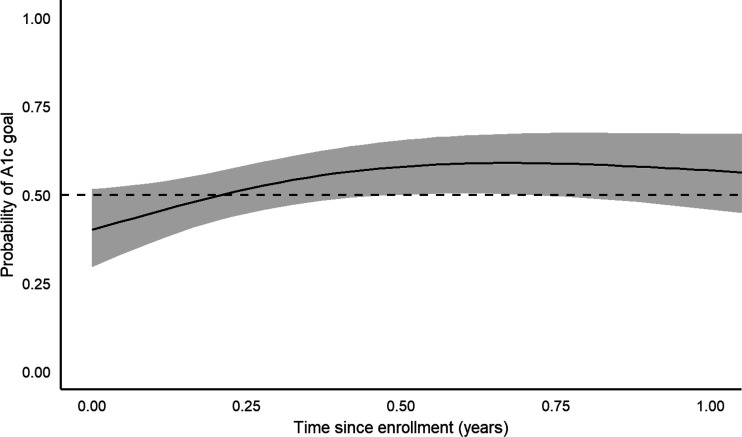
Estimated Probability of Meeting A1c Goal Over Time After Enrollment in Rural Diabetes Care Program, Guatemala